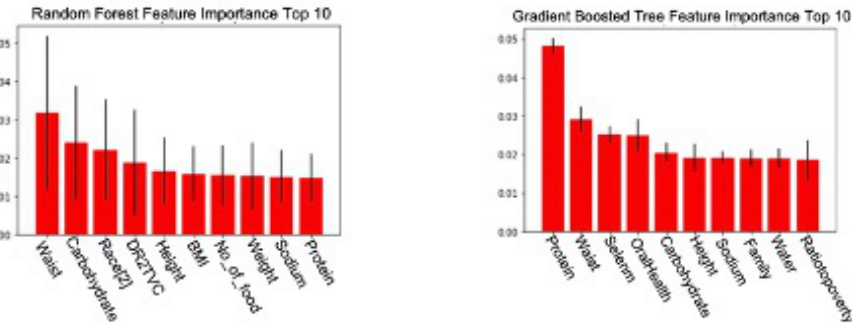
Figure 2. Top 10 important features of the ( left ) Random Forest Feature Importance Method and the ( right ) Gradient Boosted Tree Feature Importance